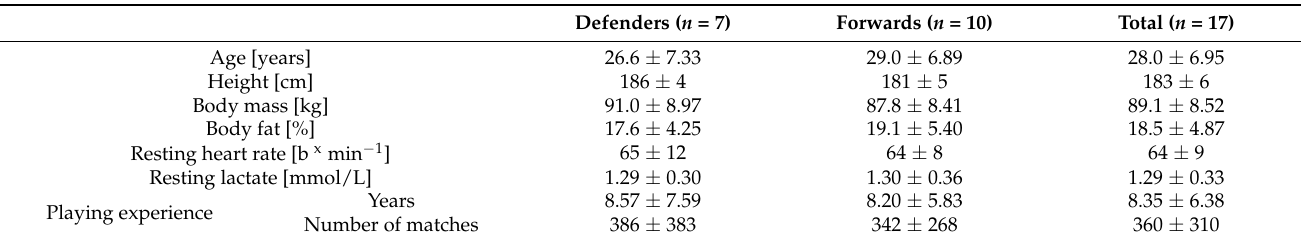
Table 1. Demographic and anthropometric characteristics of ice hockey players in relation to playing positions (mean ± standard deviation).